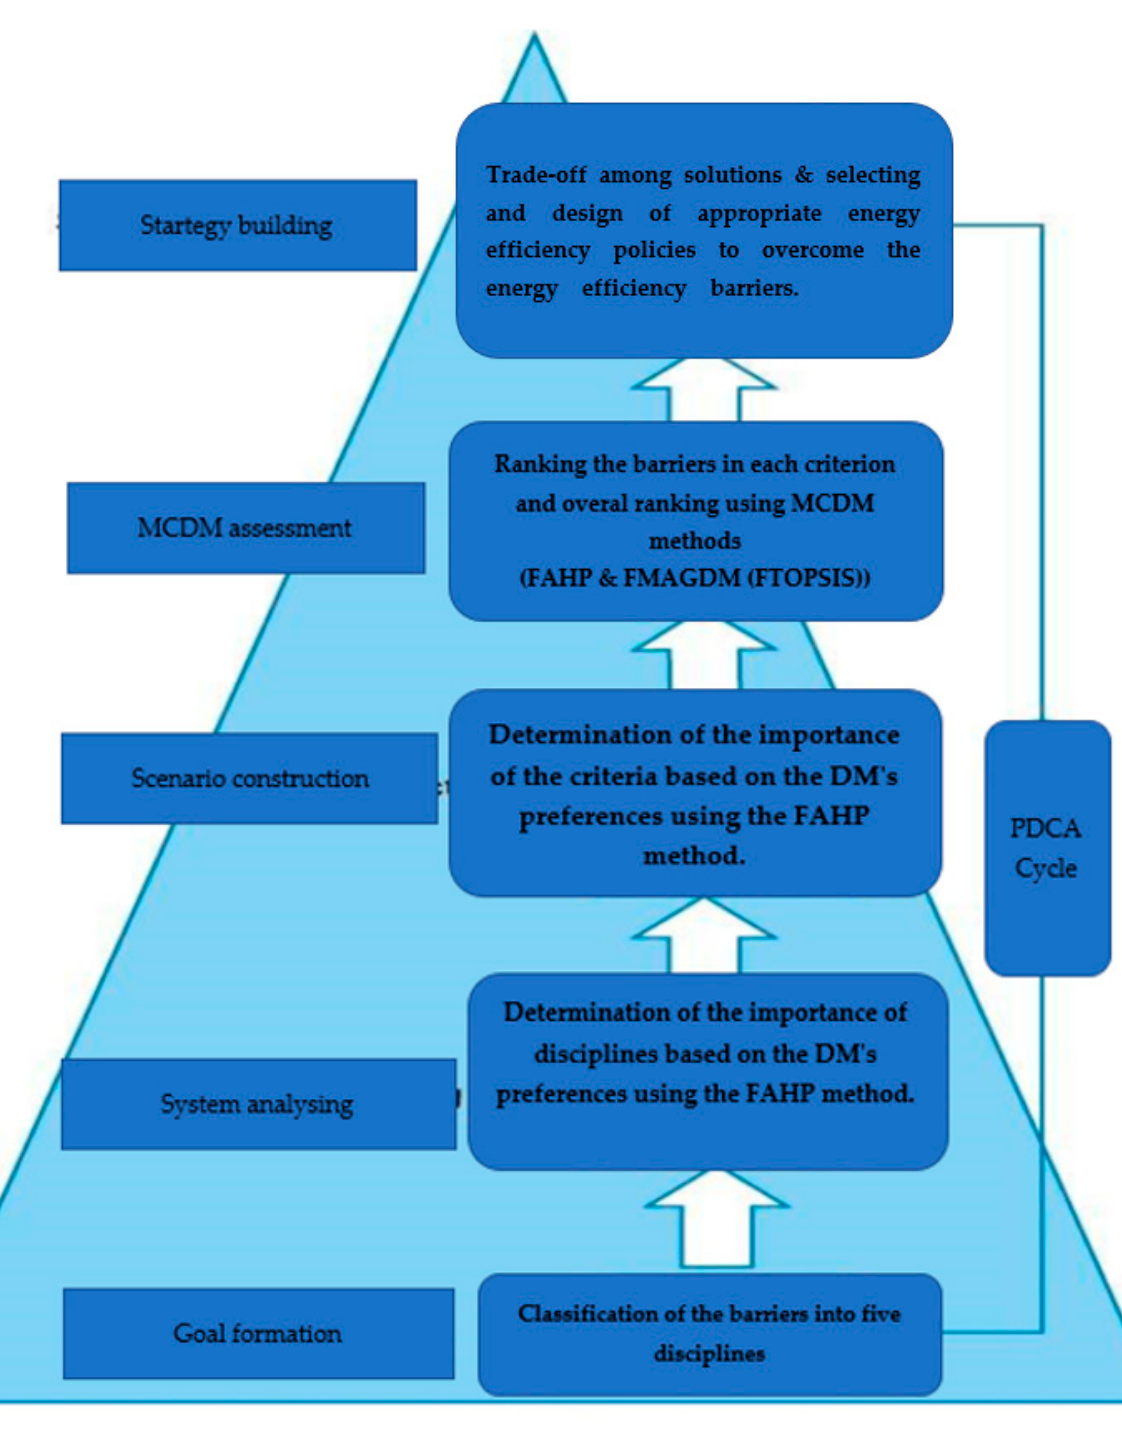
Figure 3. Transdisciplinary approach to design and develop the